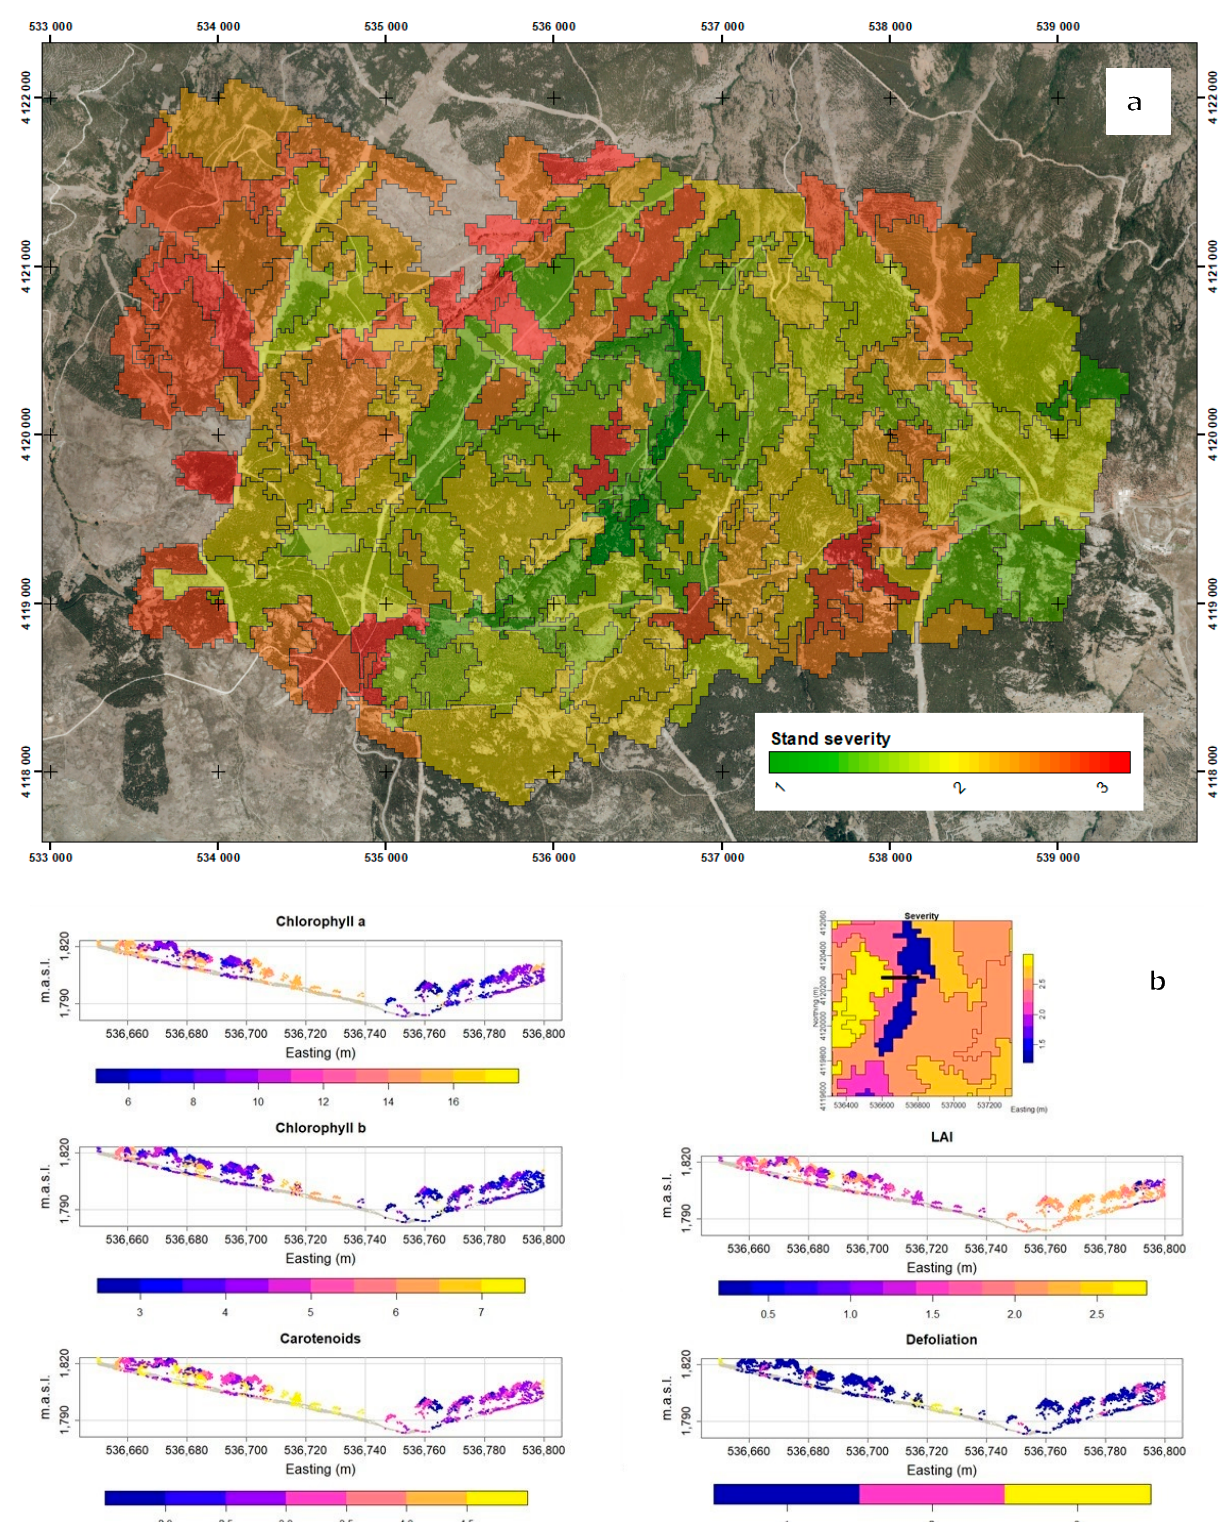
Figure 7. ( a ) Stand delineation map obtained using best semi-automatic mean-shift segmentation (Orpheo ToolBox software, OTB) Spatial ratio: 2, range ratio: 0.34, y minimum size: 100. Global Score: 31.83; and ( b ) Subsets of tree vertical profiles of some transect of stand segmentation area. The map shows the spatial distribution of similar values of severity damages in stands.